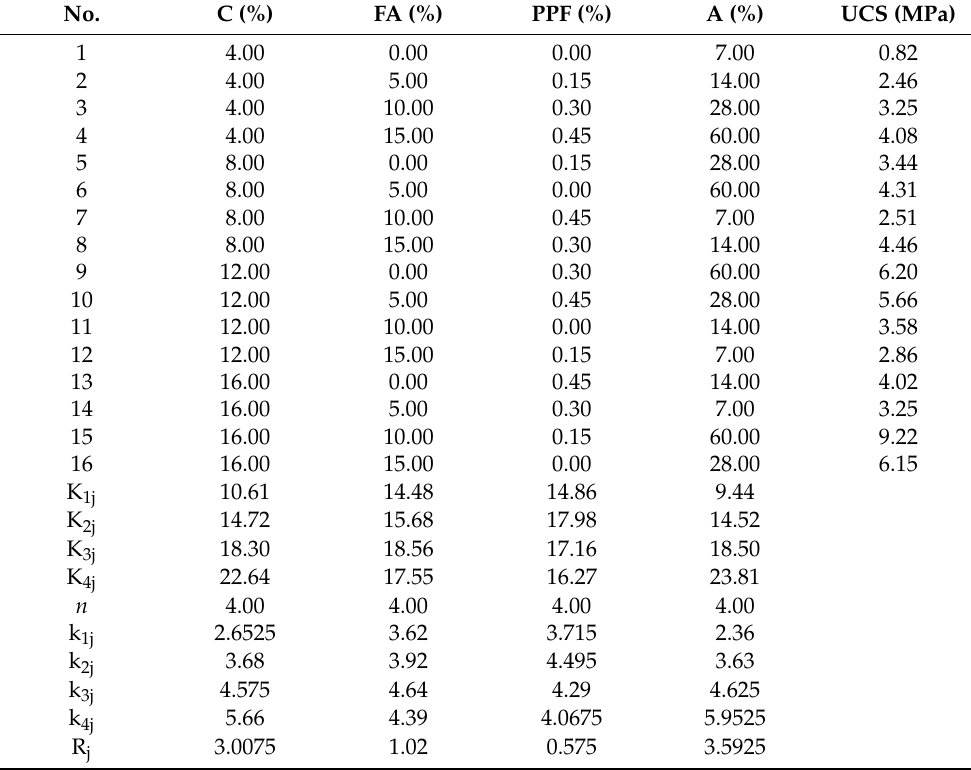
Table 3. Range analysis of orthogonal test results of fiber FA cement-modified